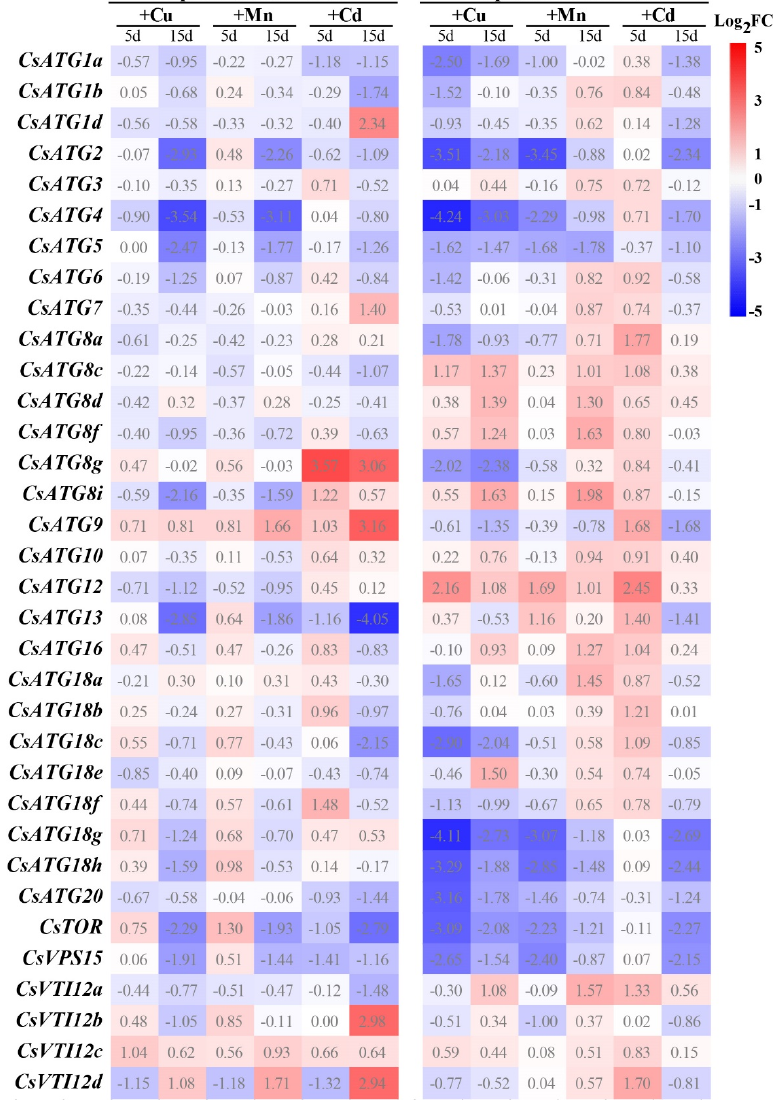
Figure 5. Expression patterns of CsATG genes under excess Cu, Mn, and Cd stresses. qRT-PCR was used to determine the relative expression levels of CsATGs in the roots and leaves of sweet orange treated with excess Cu, Mn, and Cd for 5 and 15 days. The roots or leaves sampled from plants under normal conditions for 5 and 15 days were used as controls (CK). The fold change (FC) was calculated as (relative expression of CsATGs under treatments)/(relative expression of CsATGs in the CK). The R package was used to generate a heat map based on the mean log 2 FC values of three biological replicates.